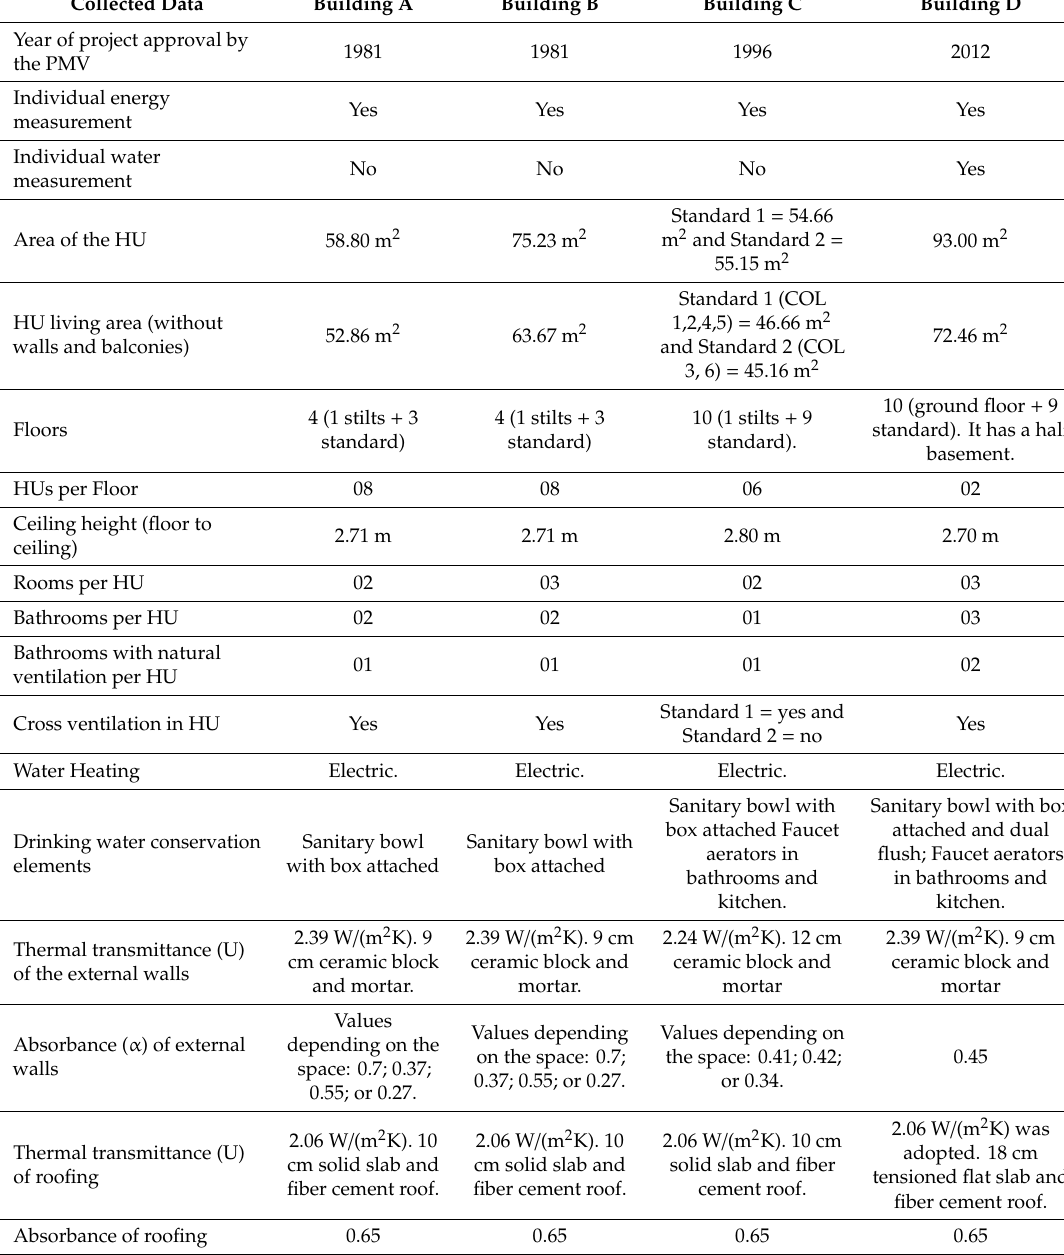
Table 1. Data collected for the representative